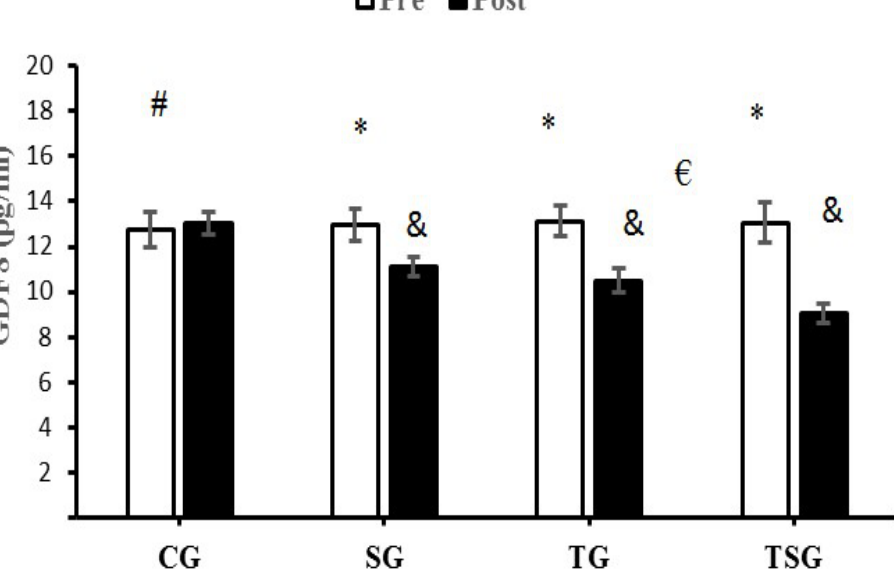
Figure 3. Pre- and post-training values (mean ± SD) for GDF8 in the control (CG), supplement (SG), training (TG), training + supplement (TSG) groups. & Significantly different from pretest values ( p < 0.05). * Significantly different from CG ( p < 0.05). # Significant interaction between time and group ( p < 0.05). € Significant time X group interaction ( p < 0.05).